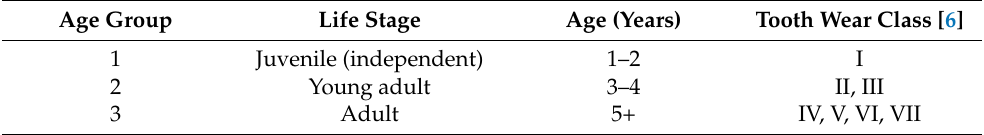
Table 1. Koala age groups corresponding to life stage, estimated age, and tooth wear class.